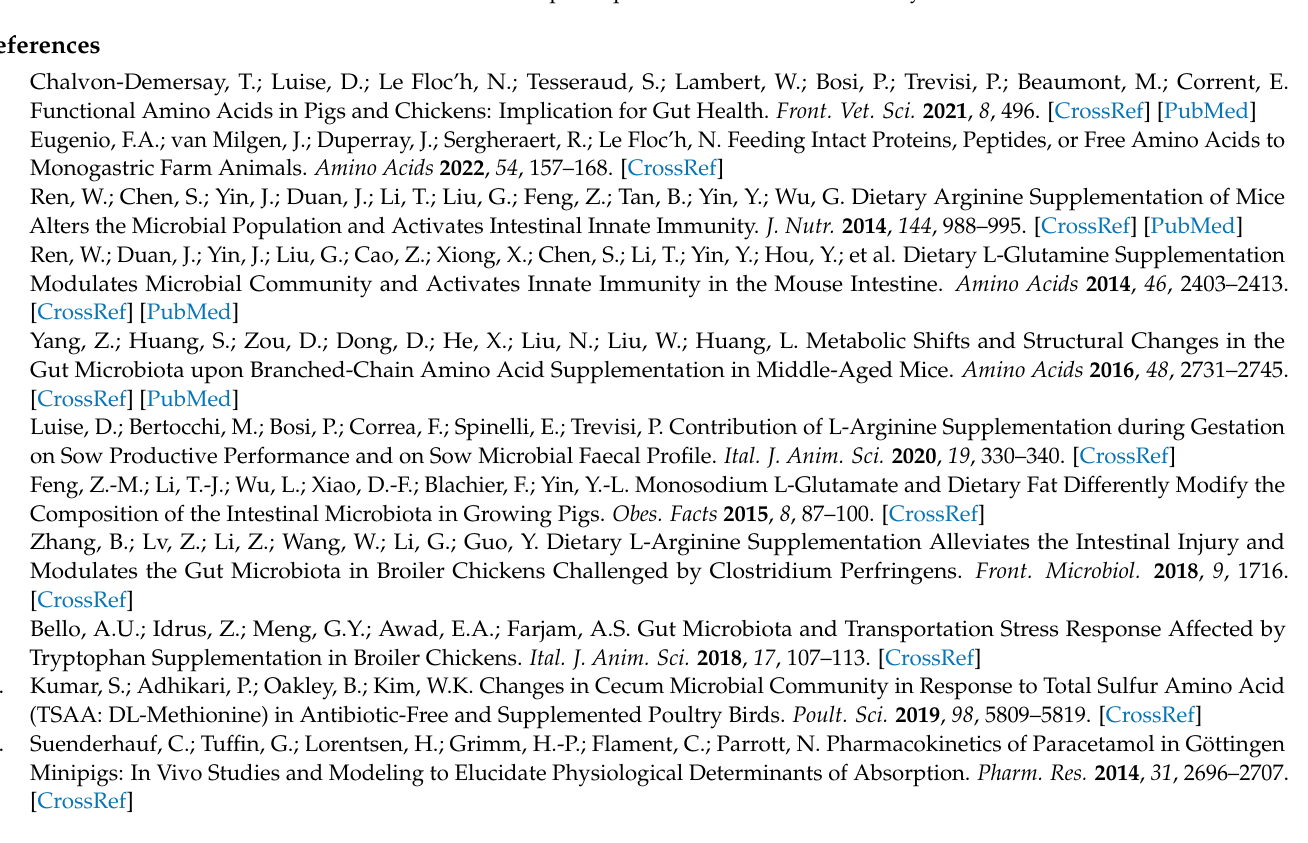
Figure S2: Average acidity, gas production, and markers of proteolytic fermentation during both blank incubations (Blank and Blank’), Figure S3: Average SCFA and lactate levels during both blank incubations (Blank and Blank’), Figure S4: PCA based on microbial community composition (family level) during the incubation of porcine colonic microbiota in presence of various amino acids versus untreated control incubations (Blank and Blank’), Figure S5: Microbial composition at phylum (A) and family level (B), at the start and after 24 h and 48 h of incubation during two blank incubations (Blank and Blank’), Table S1. Microbial composition at family level, at the start and after 24 h and 48 h of incubation during two blank incubations (Blank and Blank’), Table S2: Effect of amino acids on microbial composition (phylum level) after 24 h and 48 h of incubation, Table S3: Effect of amino acids on microbial composition (family level) after 24 h of